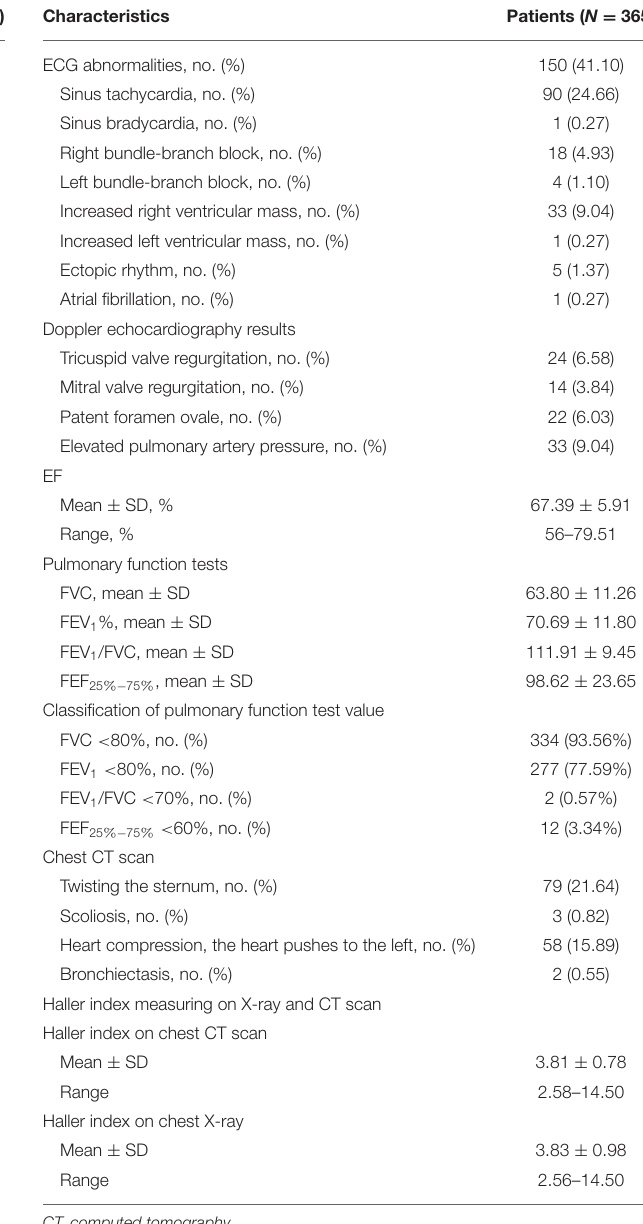
TABLE 1 | Preoperative clinical characteristics of patients. TABLE 2 | Preoperative subclinical characteristics of